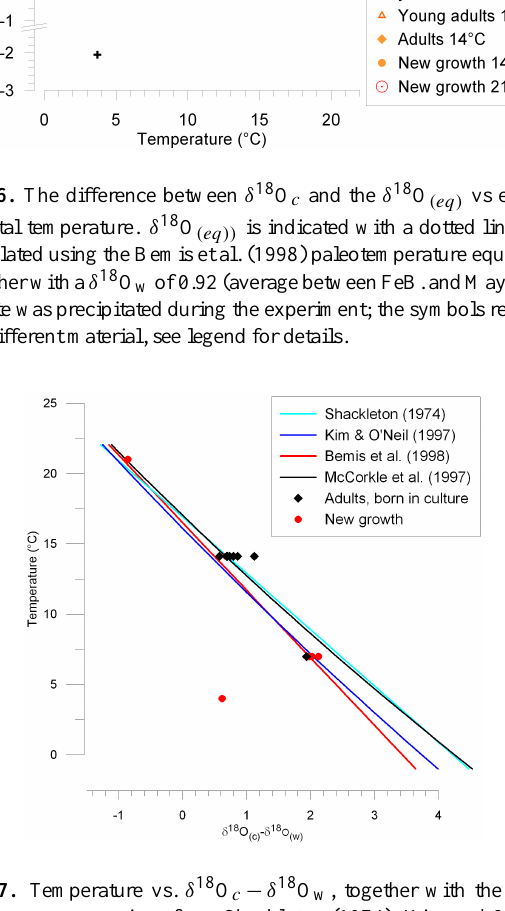
Fig. 7. Temperature vs. δ 18 O c − δ 18 O w , together with the pale- otemperature equations from Shackleton (1974), Kim and O’Neil (1997), McCorkle et al. (1997), and Bemis et al. (1998). The sym- bols represent calcite precipitated during the